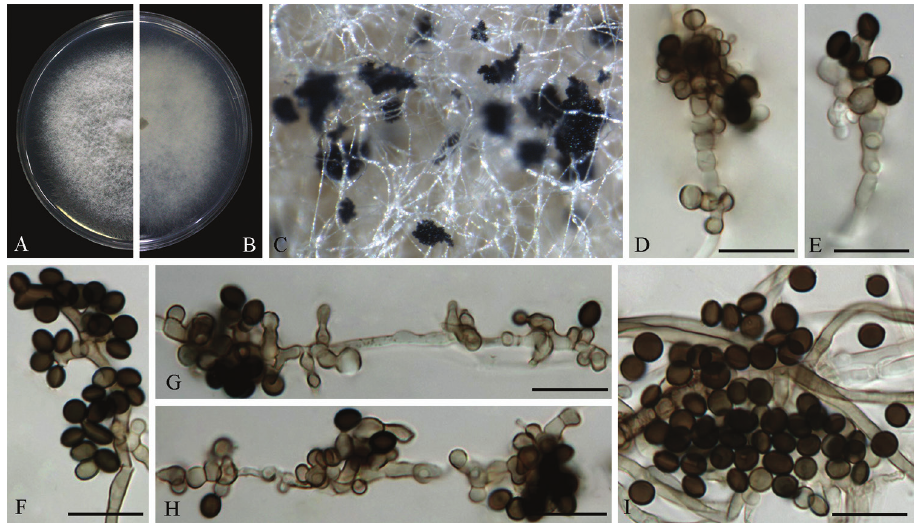
Figure 6. Arthrinium guizhouense (from ex-holotype strain CGMCC 3.18334) A–B 6 d old cultures on PDA C Colony on MEA producing conidia masses D–H Conidiogenous cells giving rise to conidia I Conidia. Scale bars = 10